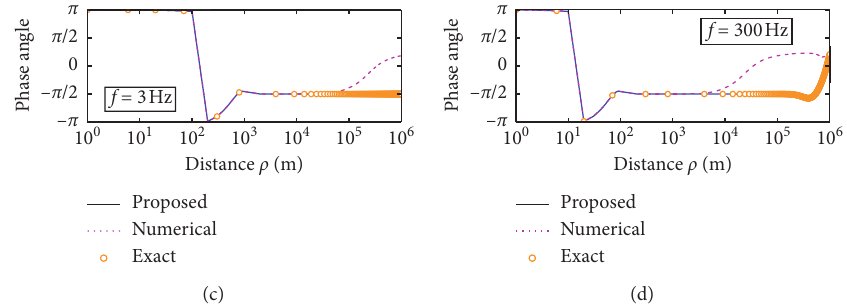
Figure 5: Amplitudes and phase angles of field component H solutions. (a, c) f � 3 Hz. (b, d) f � 300 Hz.